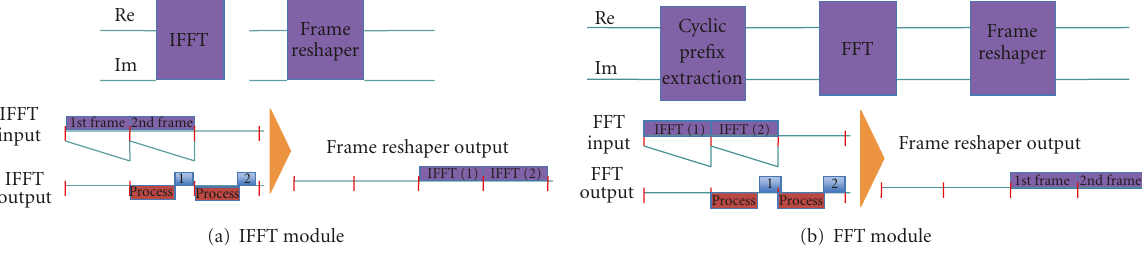
Figure 6: IFFT/FFT Reshaping module.